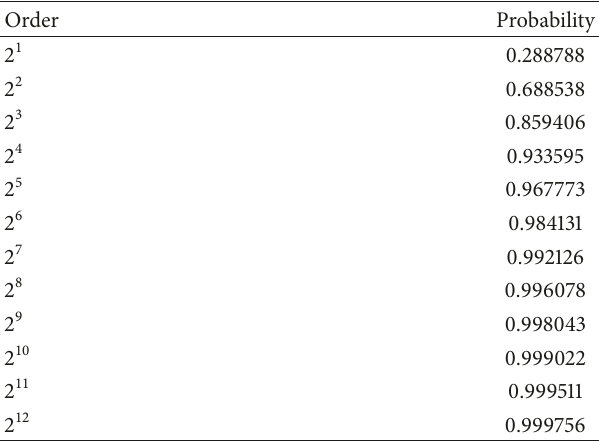
Table 1: Probability of linear independence as a function of the Galois Field size